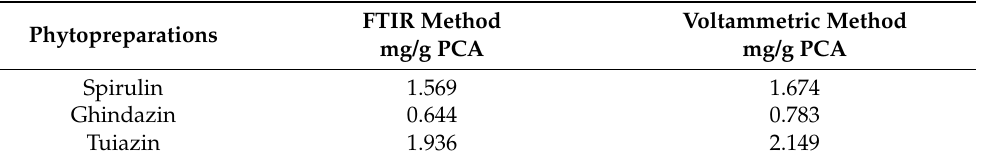
Table 6. PCA concentrations in phytoproducts obtained by the voltammetric method and the FTIR method, respectively. Phytopreparations.